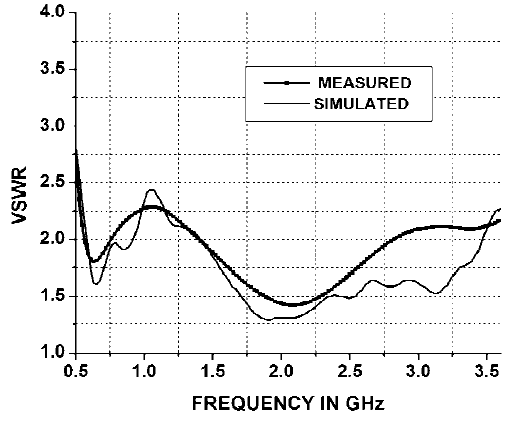
Figure 8: Simulated and measured VSWR of Canonical Sleeve Antenna (CSA)